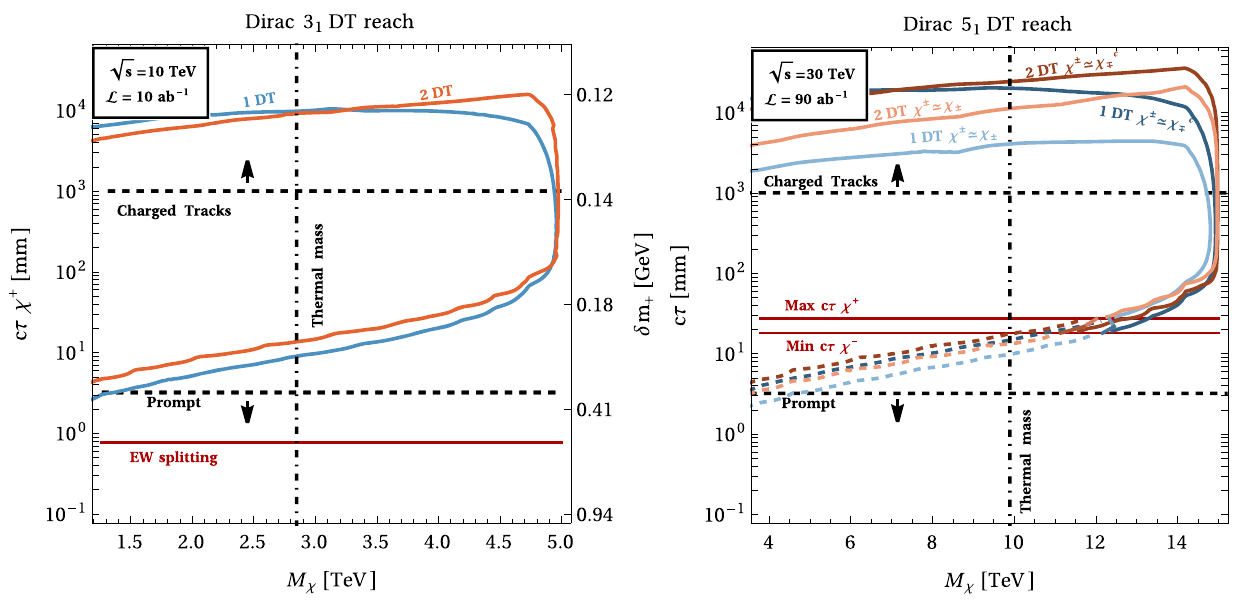
Fig. 8 Sensitivity at 95% CL from DT searches as a function of M χ and the proper lifetime of the charged particle χ + . The mass splitting δ m + is also shown in the extra vertical axis in two upper panels. In the lower panels, the two different contours for each search channel correspond to the different physical situations where the heavy mass